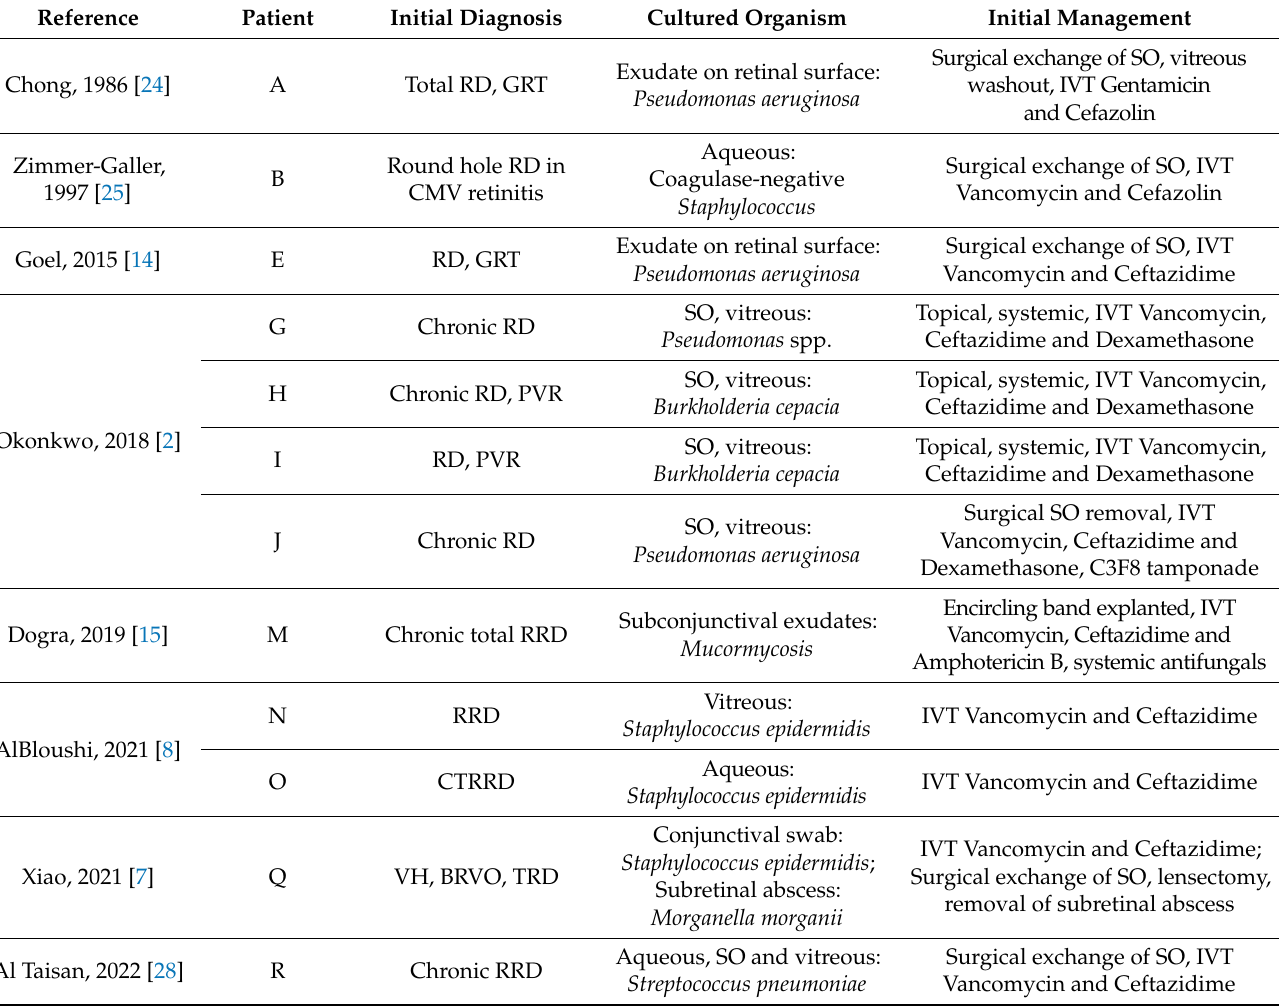
Table 3. Summary of culture positivity from previous reports of endophthalmitis in silicone oil- filled